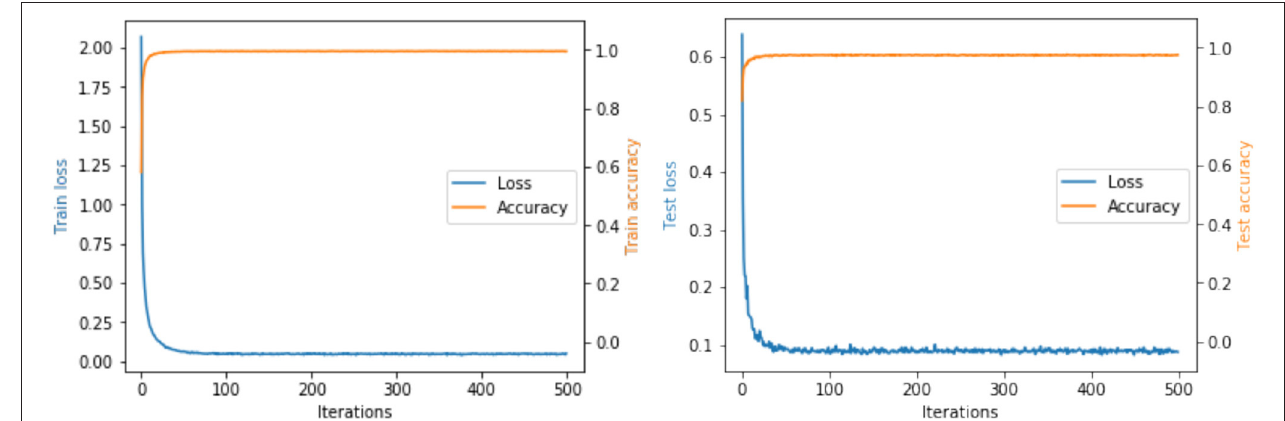
FIGURE 4 | Accuracy and loss during CRN training and testing.